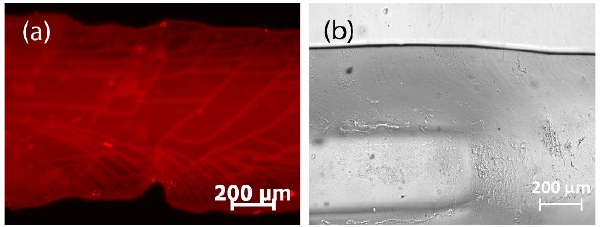
Figure 17. Microfluidic chip replicated from a laser-engraved casting mold. ( a ) Non-leaky channel visualized with fluorescent rhodamine B solution. ( b ) Enlarged channel after acetone vapor polishing.